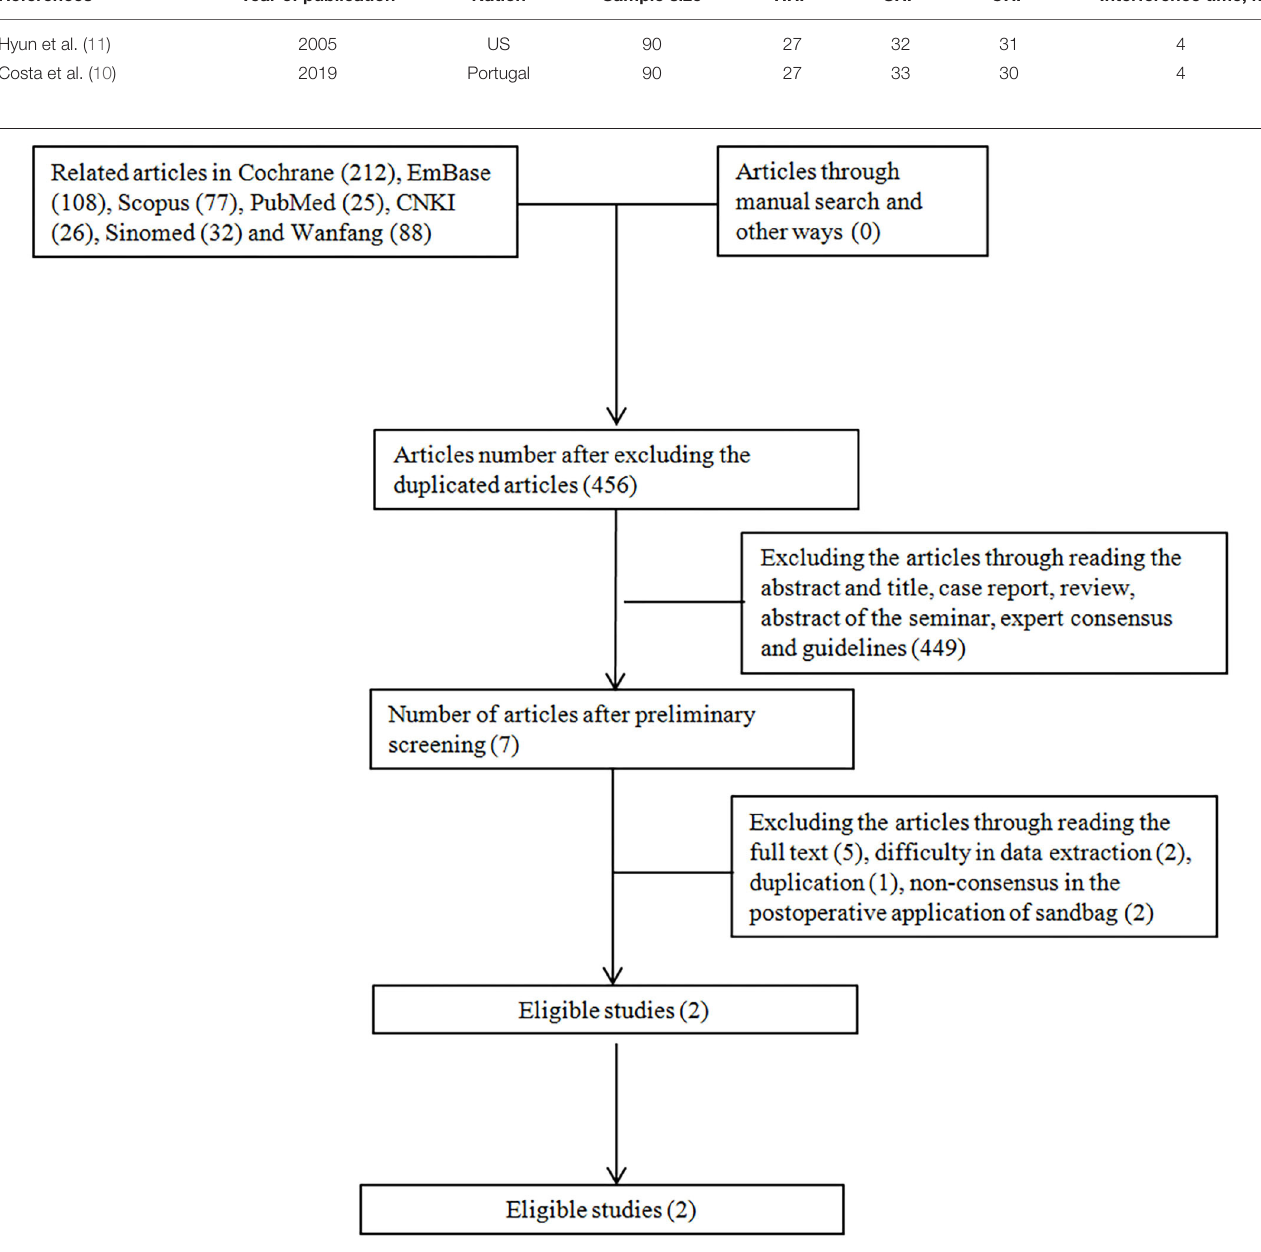
FIGURE 4 | Flowchart of the